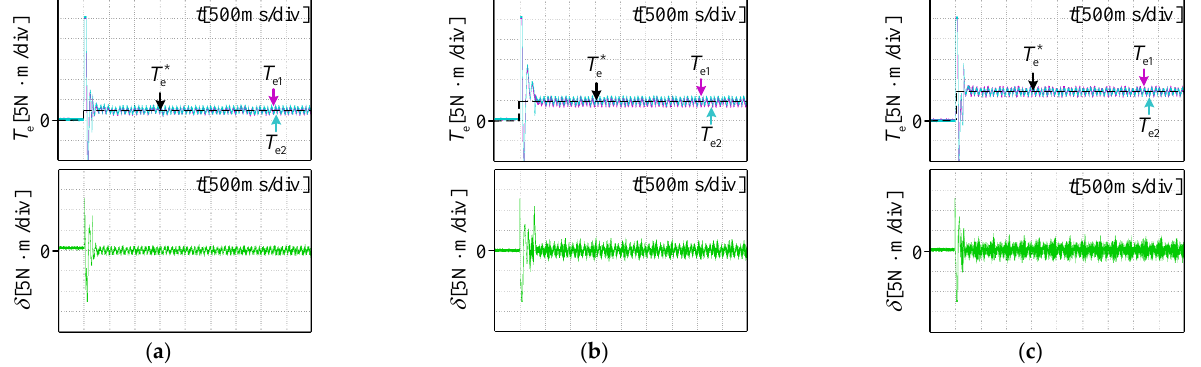
Figure 13. Steady-state waveforms of closed-loop control strategy based on master-slave structure: ( a ) load torque is 5N m, ( b ) load torque is 10N m and ( c ) load torque is 15N m.